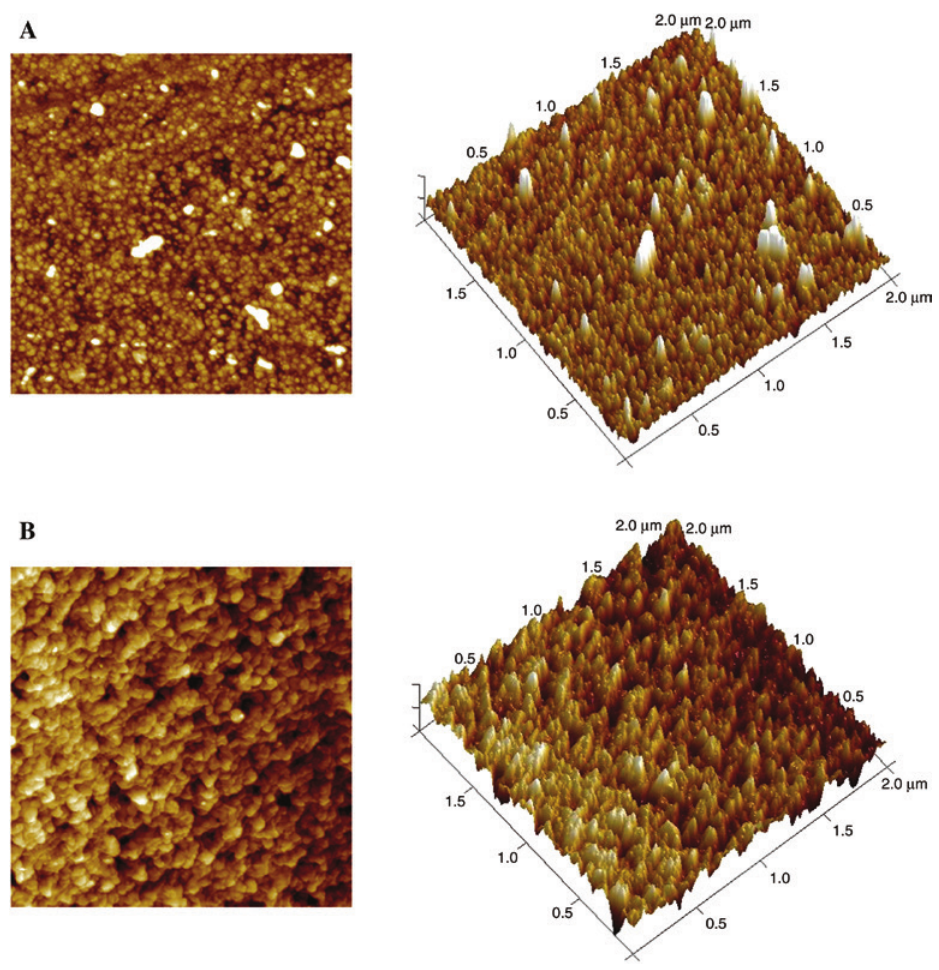
Figure 1: (A) 2-D and 3-D AFM images of the film grown at 400 ° C. (B) 2-D and 3-D AFM images of the film post-annealed at 800 °